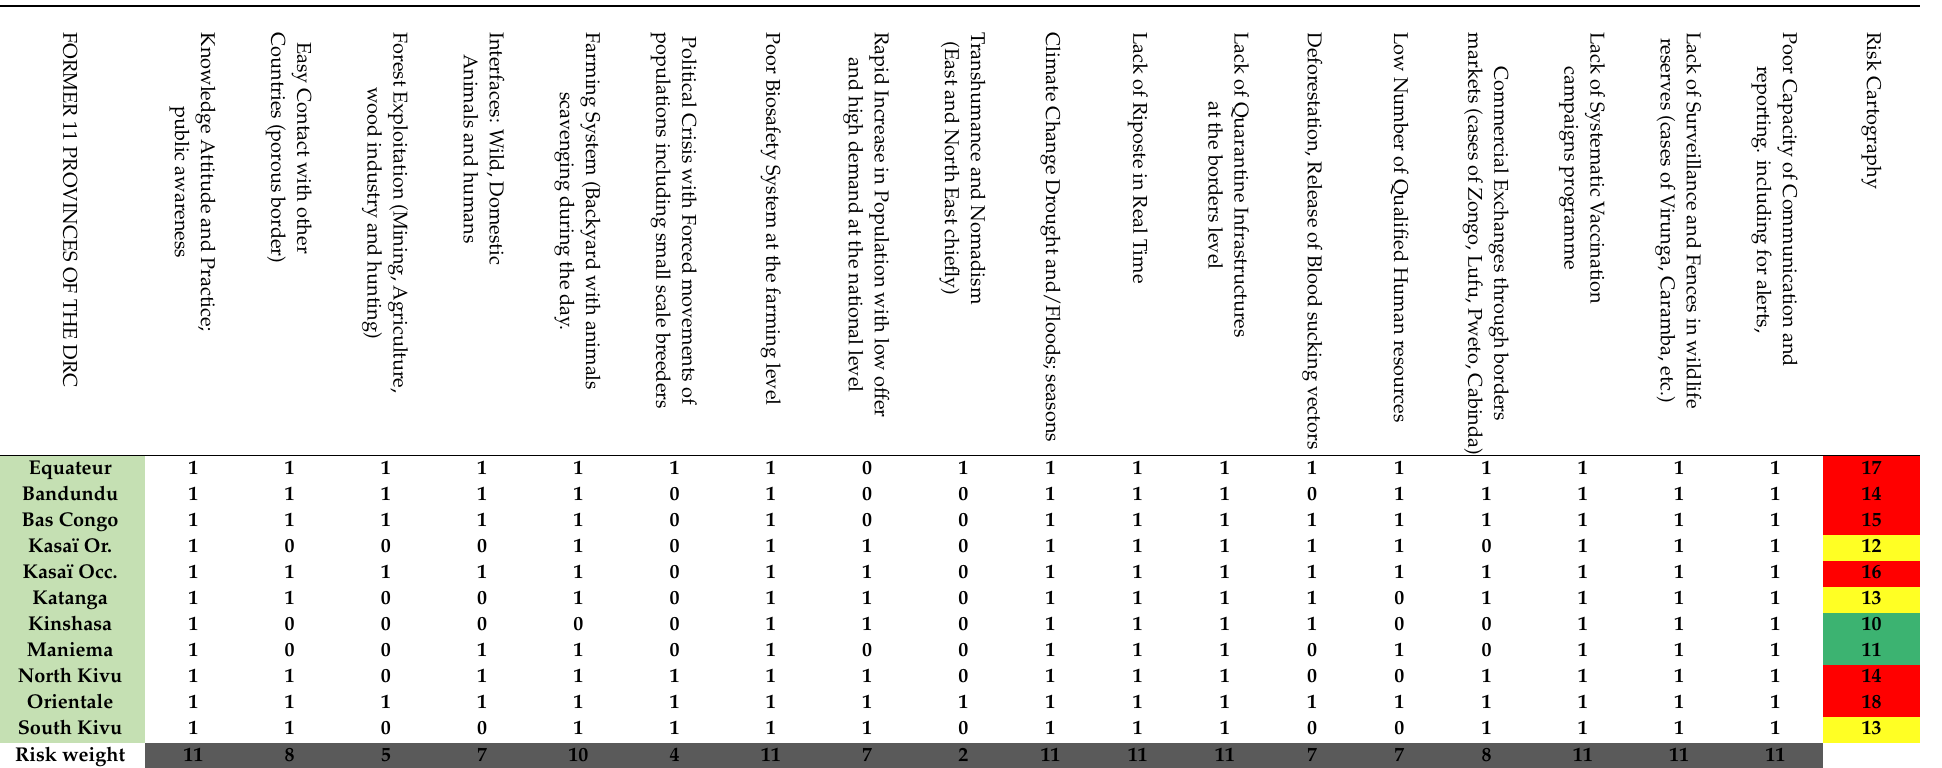
Table 1. Risk factor assessment of different provinces of the DRC. A score of 1 indicates there is a potential risk within the area; 0: there is no potential risk within the area. The provinces with a risk cartography score of ≥ 14 indicates at very high risk (highlighted red); ≥ 12 and <14: at high risk (highlighted yellow) and ≤ 11: at low risk or are provinces with several disease-free areas (highlighted green). This is the current picture in the DRC, which might be exploited as a starting point, if a target control strategy is adopted by the government within the SADC